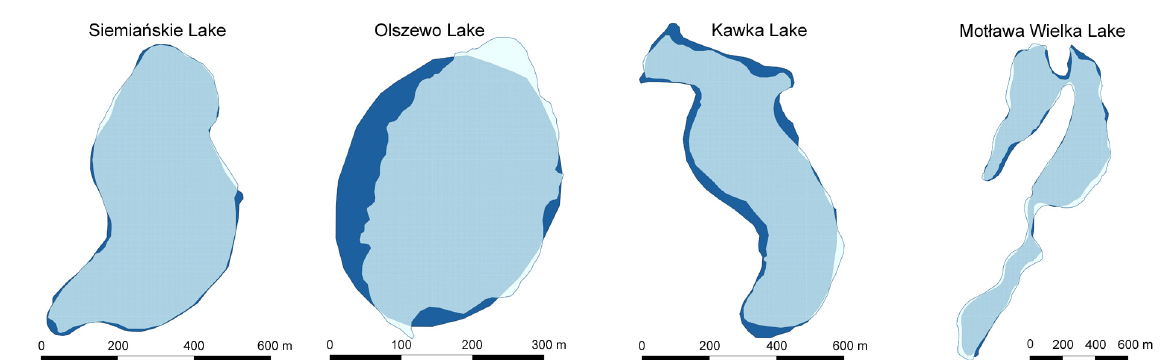
Fig. 4. Set of lake maps show the places, ways and rates of lake disappearance in years 1928 and 2014 (a – land area occupied by the lake in 2014, b – lake range in 2014 in the lake border from 1928) for selected lakes in the Iława Lakeland Landscape